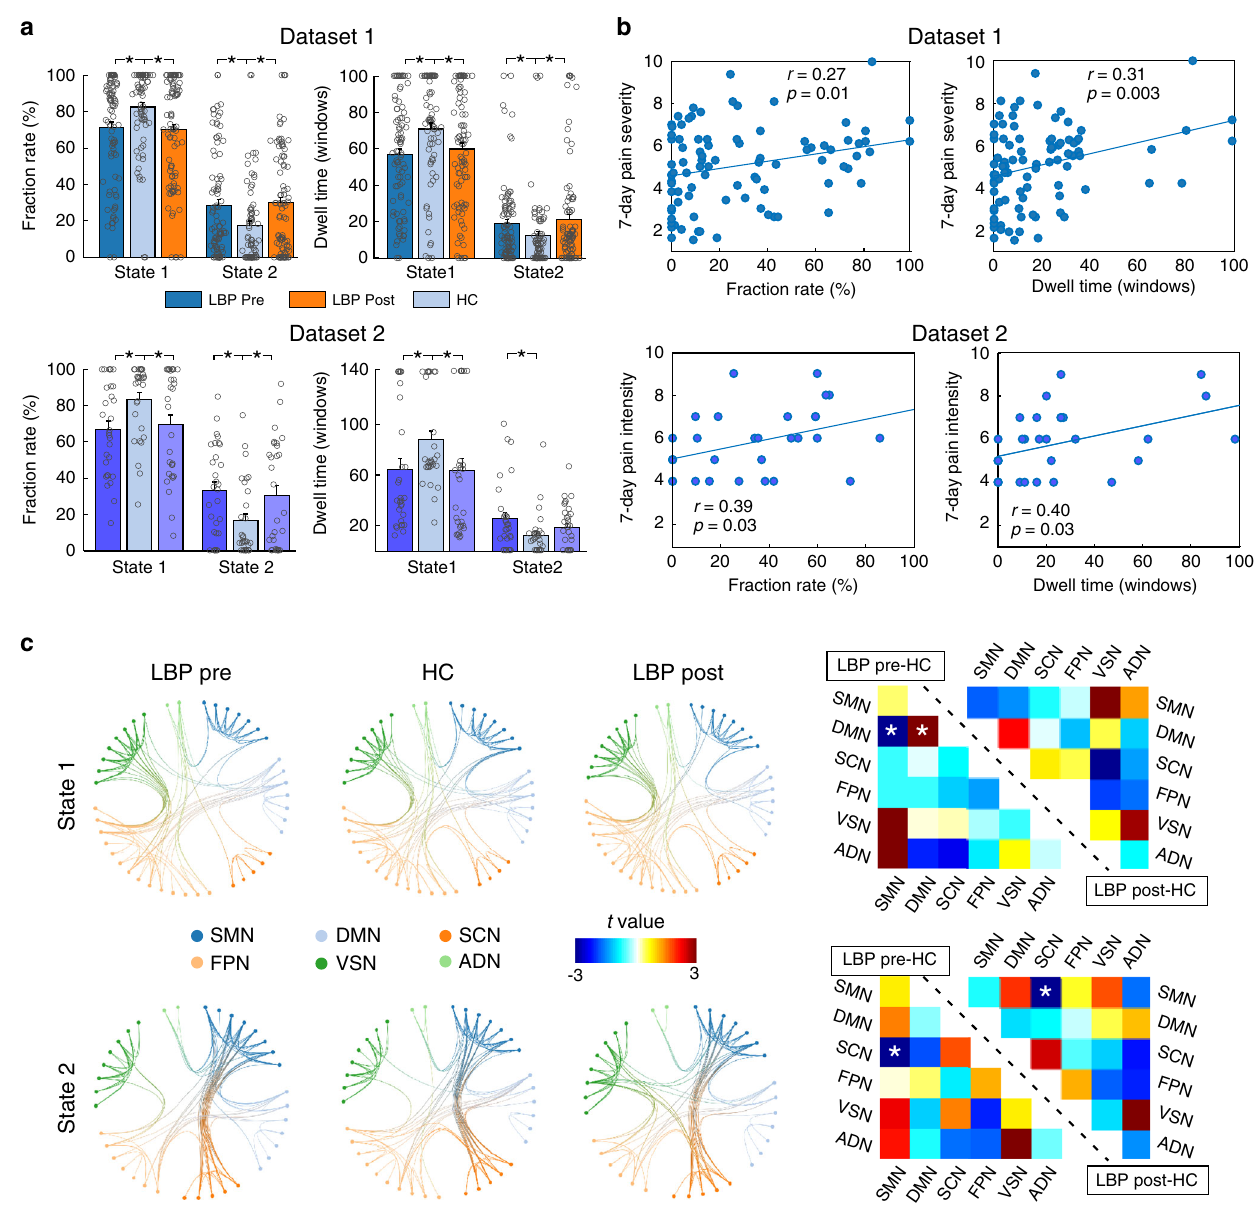
Fig. 3 Group differences of occurrences and dFNC patterns in cLBP patients and HCs. a In Dataset 1, cLBP patients (pre- and post-maneuver) had signi fi cantly lower fraction rate and dwell time in State 1 and higher fraction rate and dwell time in State 2. This fi nding was validated in Dataset 2. Data are presented as mean values± SEM. Each circle represents the data for an individual. N = 90 and 74 for cLBP patients and HCs in Dataset 1, respectively, and N = 30 and 30 for cLBP patients and HCs in Dataset 2, respectively. b The fraction rate and dwell time of cLBP patients in State 2 were positively correlated with pain severity/intensity in the past 7 days. Note that pain severity and intensity are two different measures but are typically strongly correlated. c cLBP patients and HCs had similar patterns of connectivity in the two states, but they differed in the strength of connections. Asterisks represent signi fi cant difference at two-sided p FDR < 0.05 for t -test. SMN sensorimotor network, DMN default mode network, SCN subcortical network, FPN frontoparietal network, VSN visual network, ADN auditory network. Source data are provided as a Source Data fi